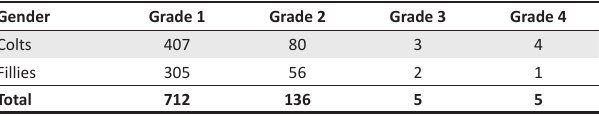
TABLE 4. Gender versus recurrent laryngeal neuropathy grade in the present study.